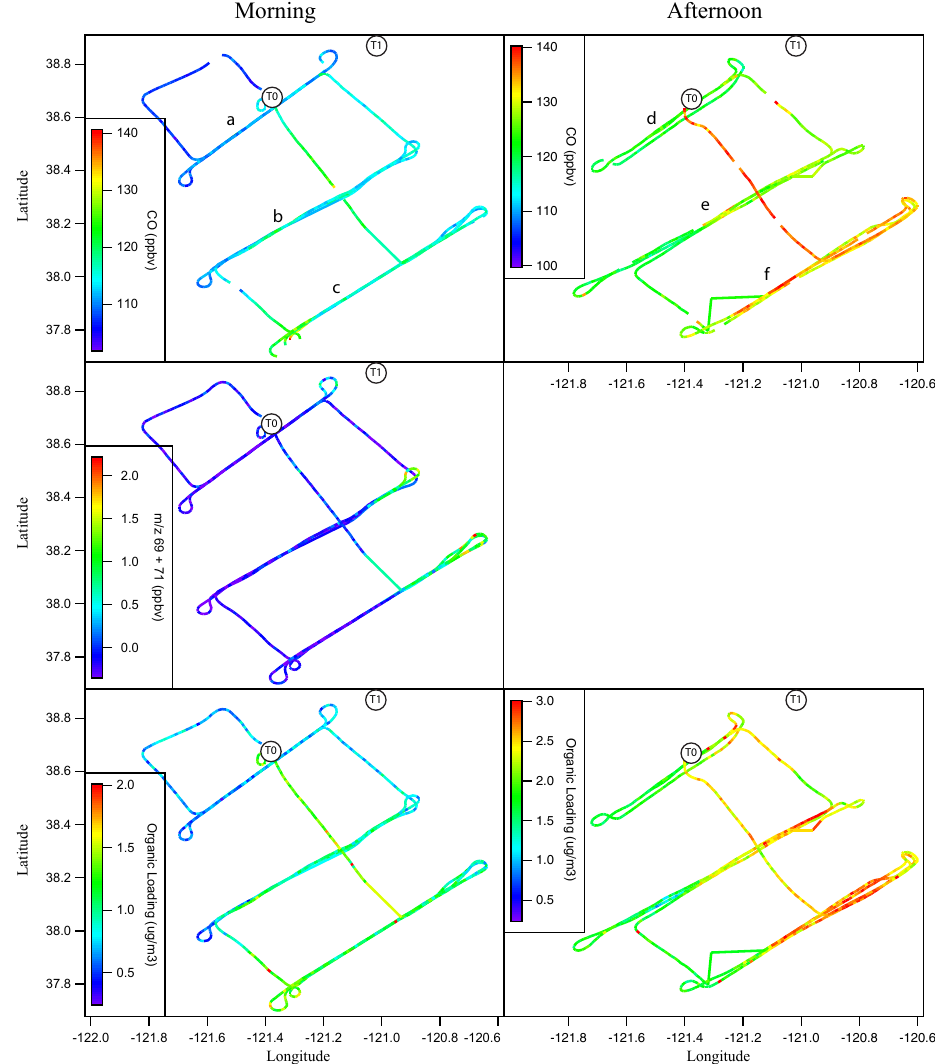
Fig. 9. 12 June morning and afternoon flight tracks colored by CO, the sum of m / z 69 (isoprene) and 71 (MVK+MACR), and OA concen- trations. Note the low concentrations of biogenic tracers across the flight domain. PTR-MS data were not available in the afternoon flight. Letters are used to identify important portions of the flight track and correspond to the letters in shown in Fig. 10.